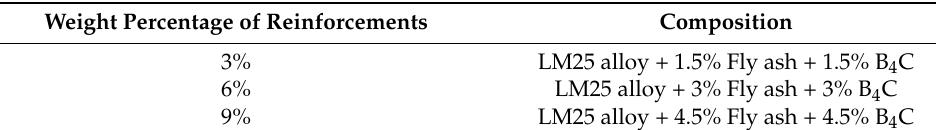
Table 3. Weight compositions of hybrid composites.